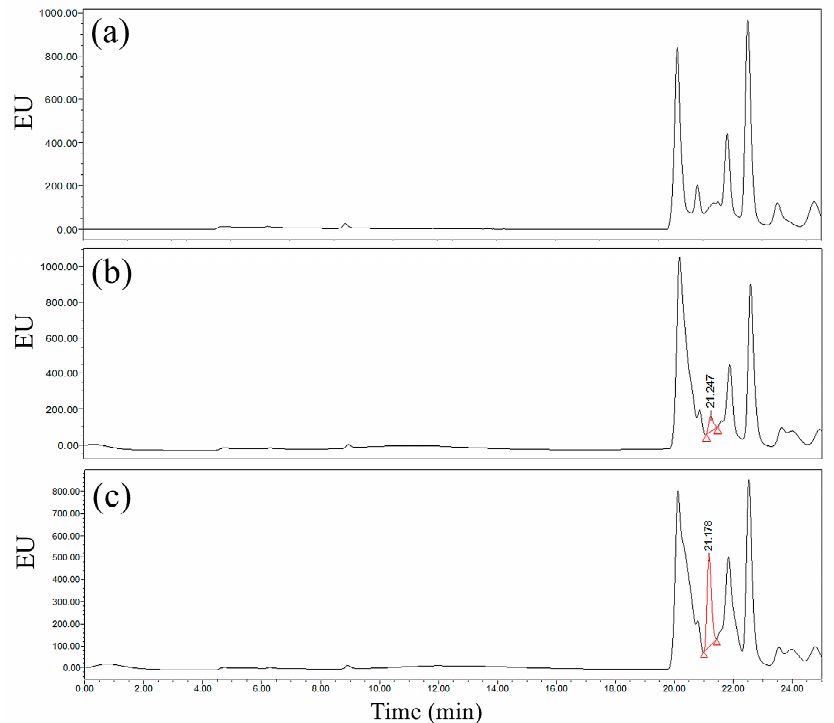
Figure 7. Chromatograms on the T 3 column for the ( a ) sample derived from blank control, ( b ) sample derived from the 0.1 mg/L GLUF-P matrix solution, and ( c ) sample derived from the 0.5 mg/L GLUF-P matrix solution.